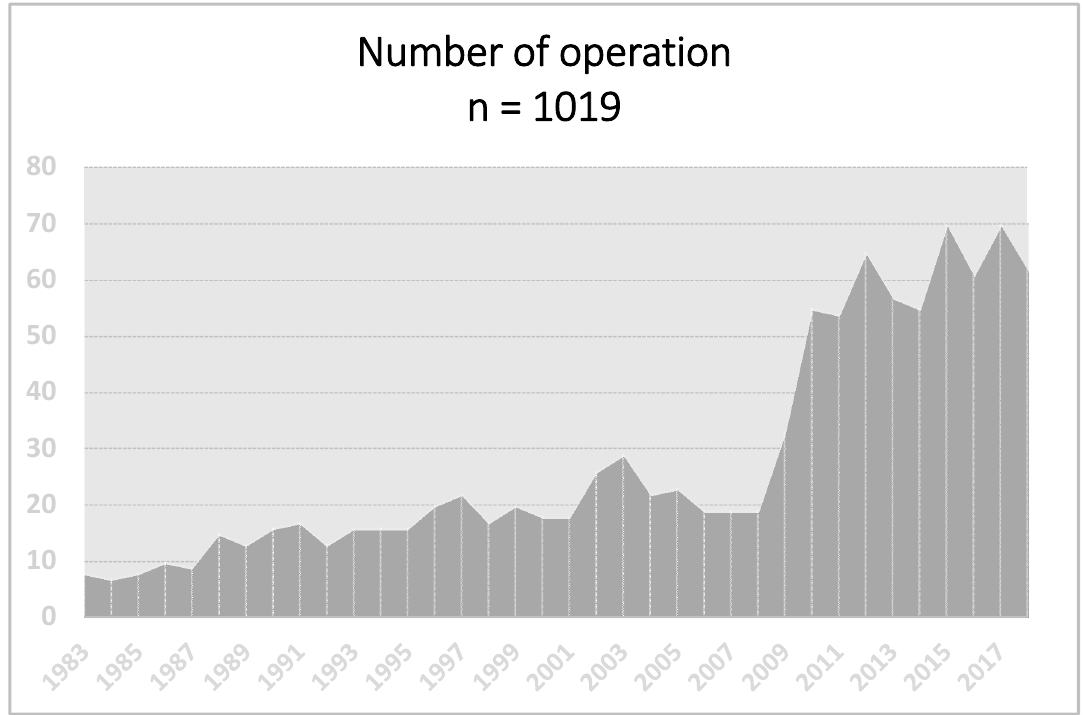
Figure 1. Number of operations in years 1983–2018.